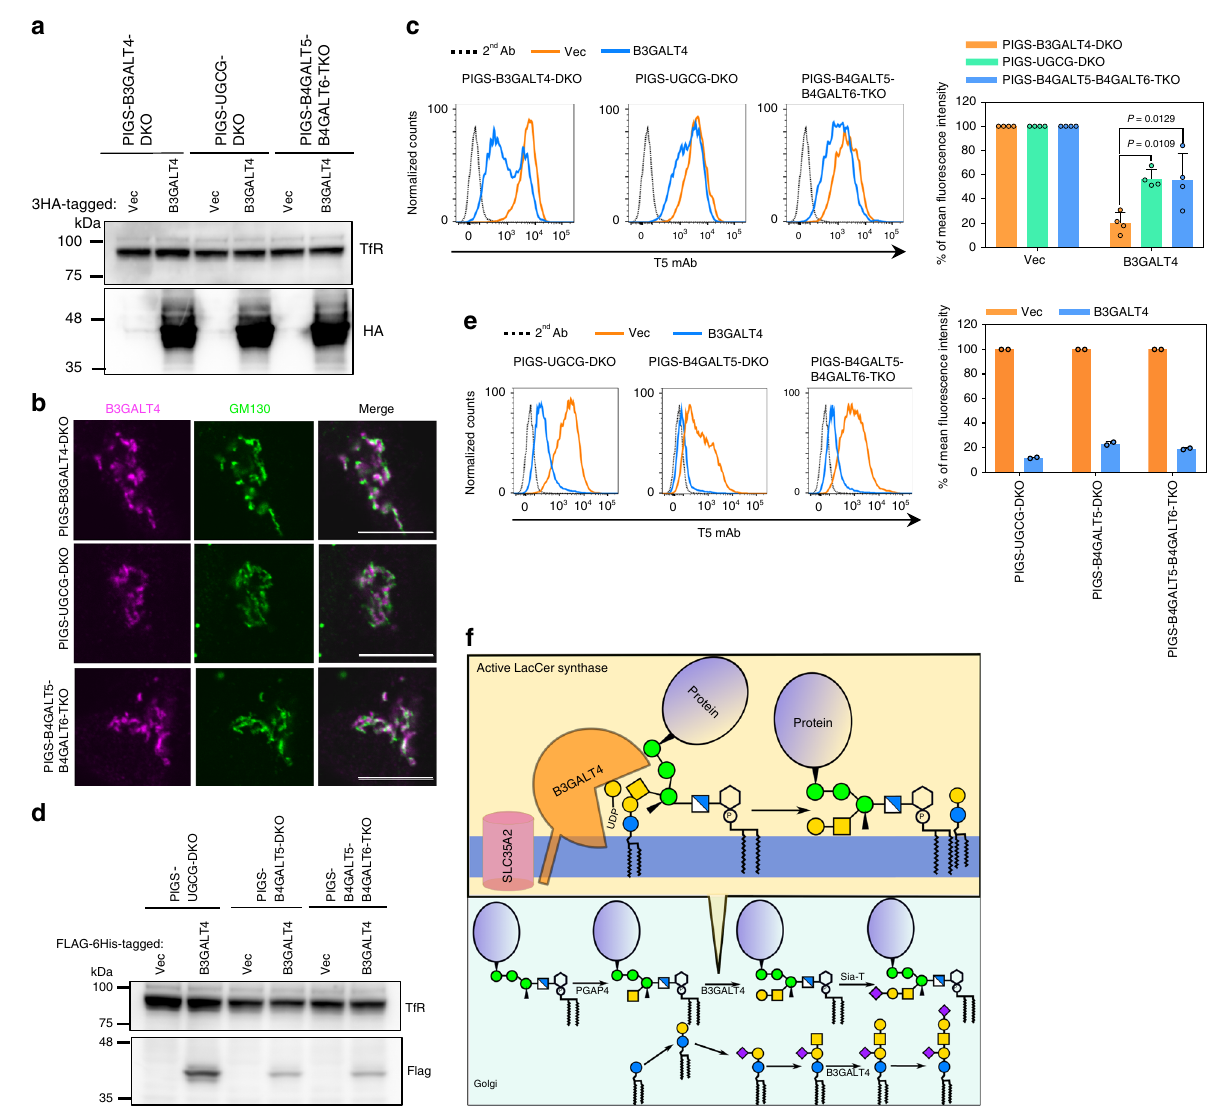
Fig. 6 LacCer enhances B3GALT4 activity toward GPI-GalNAc. a Western blotting of B3GALT4-3HA transiently overexpressed in PIGS-UGCG-DKO, PIGS-B4GALT5-DKO, and PIGS-B4GALT5-B4GALT6-TKO cells. b Representative fl uorescence images of 3HA-tagged B3GALT4 in PIGS-B3GALT4-DKO, PIGS-UGCG-DKO, and PIGS-B4GALT5-B4GALT6-TKO HEK293 cells. GM130, a marker for cis-Golgi. Scale bar, 10 μ m. c Left: PIGS-UGCG-DKO, PIGS- B4GALT5-DKO, and PIGS-B4GALT5-B4GALT6-TKO cells transiently expressing pME-B3GALT4-3HA were stained with T5 mAb. Right: Quantitative data of MFI from four independent experiments (mean ± SD, n = 4). P values are from one-way ANOVA followed by Dunnett ’ s test for multiple comparisons to PIGS-B3GALT4-DKO cells. d Western blotting of FLAG-6His tagged B3GALT4. Lysates of PIGS-UGCG-DKO, PIGS-B4GALT5-DKO, and PIGS-B4GALT5- B4GALT6-TKO cells stably expressing empty vector (Vec) and B3GALT4 were analyzed. TfR, a loading control. e Left: PIGS-UGCG-DKO, PIGS-B4GALT5- DKO, and PIGS-B4GALT5-B4GALT6-TKO cells stably expressing B3GALT4 were stained with T5 mAb. Right: Quantitative data of MFI from two independent experiments (mean ± SD, n = 2). f Schematic of LacCer enhanced galactose modi fi cation on GPI-GalNAc by B3GALT4 in the Golgi. Source data for ( c ) and ( e ) are provided as a Source Data fi